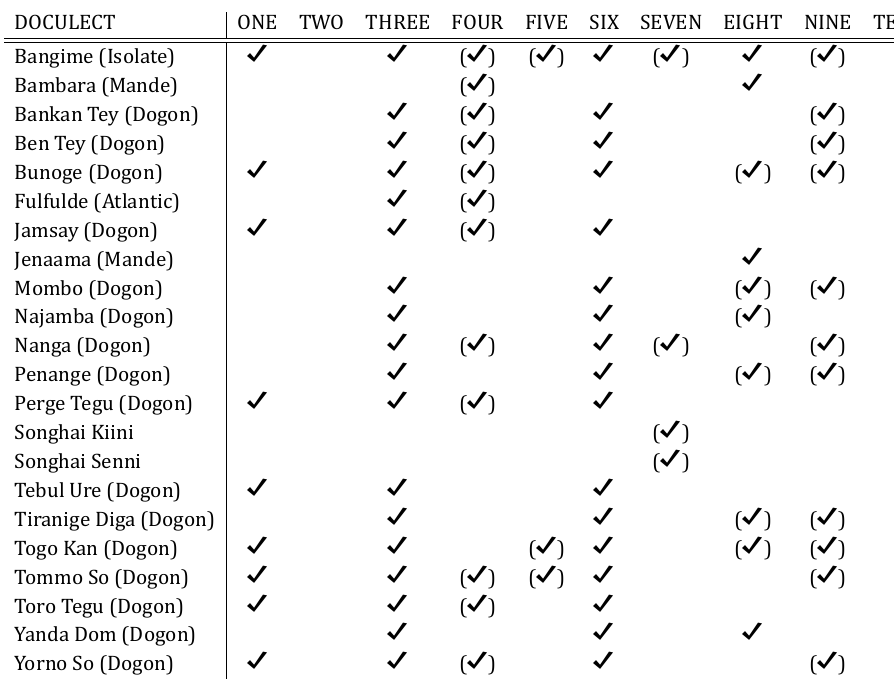
Table 5: Shared numerals from one to